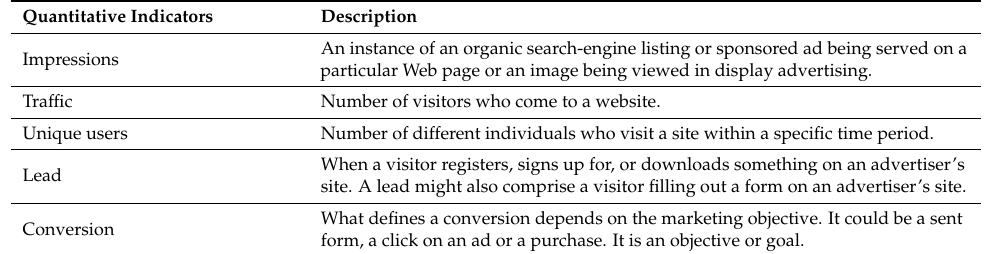
Table 6. Quantitative Indicators in